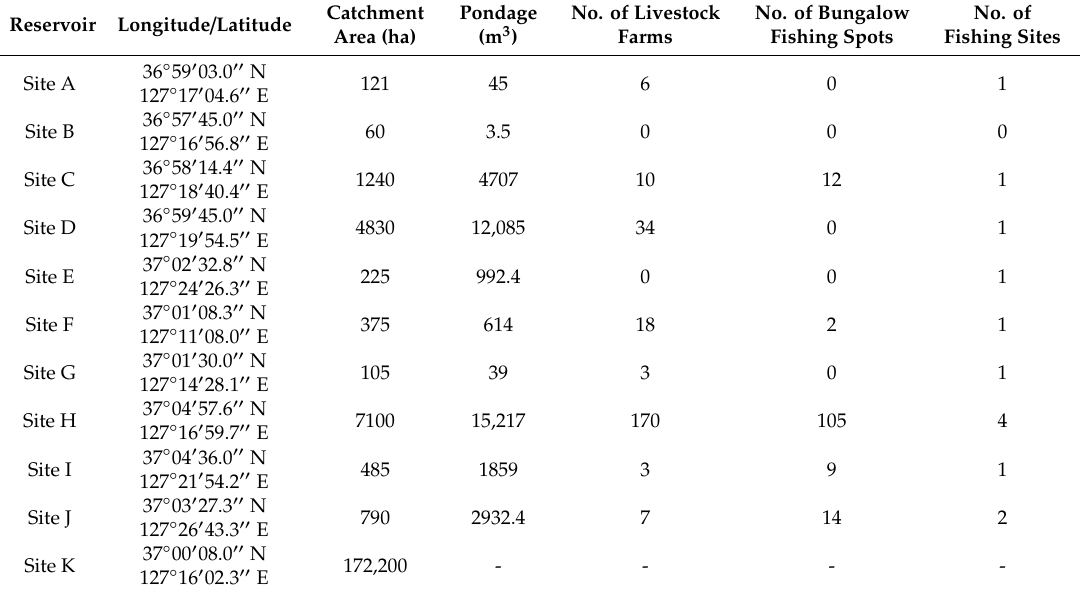
Table 2. Environmental characteristics of the sampling